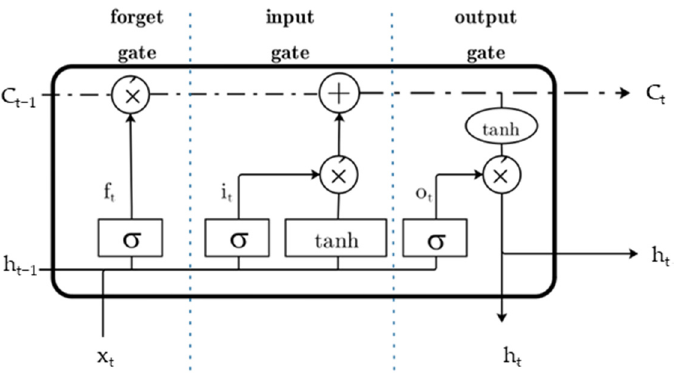
Figure 8. Schematic diagram of LSTM-cell model structure module.